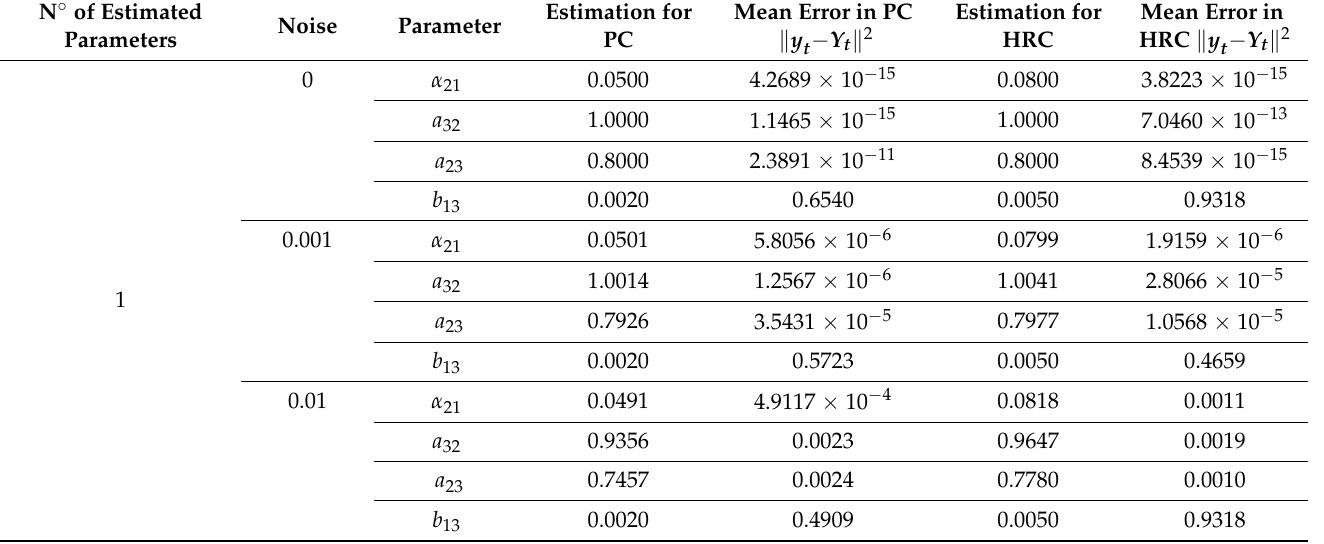
Table 2. Results of parameters’ estimation with PSO, considering one, two, and three parameters estimated at each time, with different noise. PC: physiological condition; HRC: high rate condition. N ◦ of Estimated Estimation Parameter Parameters